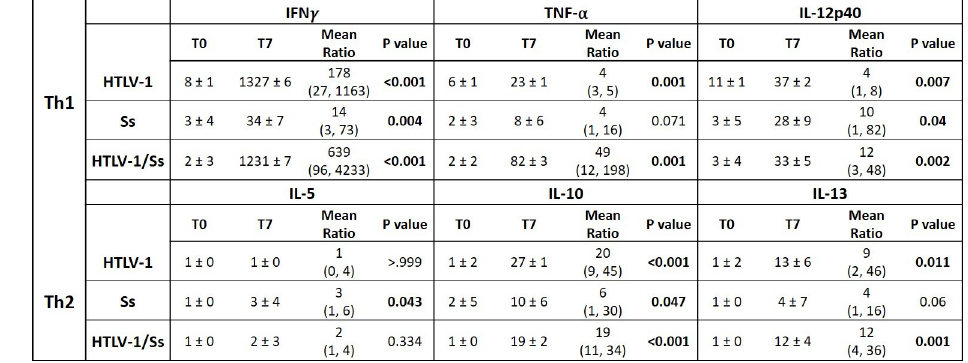
Fig 5. Comparison of human Th1 and Th2 cytokine levels measured in serum from mice infected with HTLV-1, Strongyloides stercoralis ( Ss ) or coinfected with both HTLV-1 and S. stercoralis. Measurements were taken of preinfection sera (T0) and at 7-weeks post infection (T7). Geometric mean and standard deviations of cytokine levels are presented. The estimated mean ratios as well as 95% confidence intervals are presented with P values. For clarity of presentation all numbers are rounded without decimal